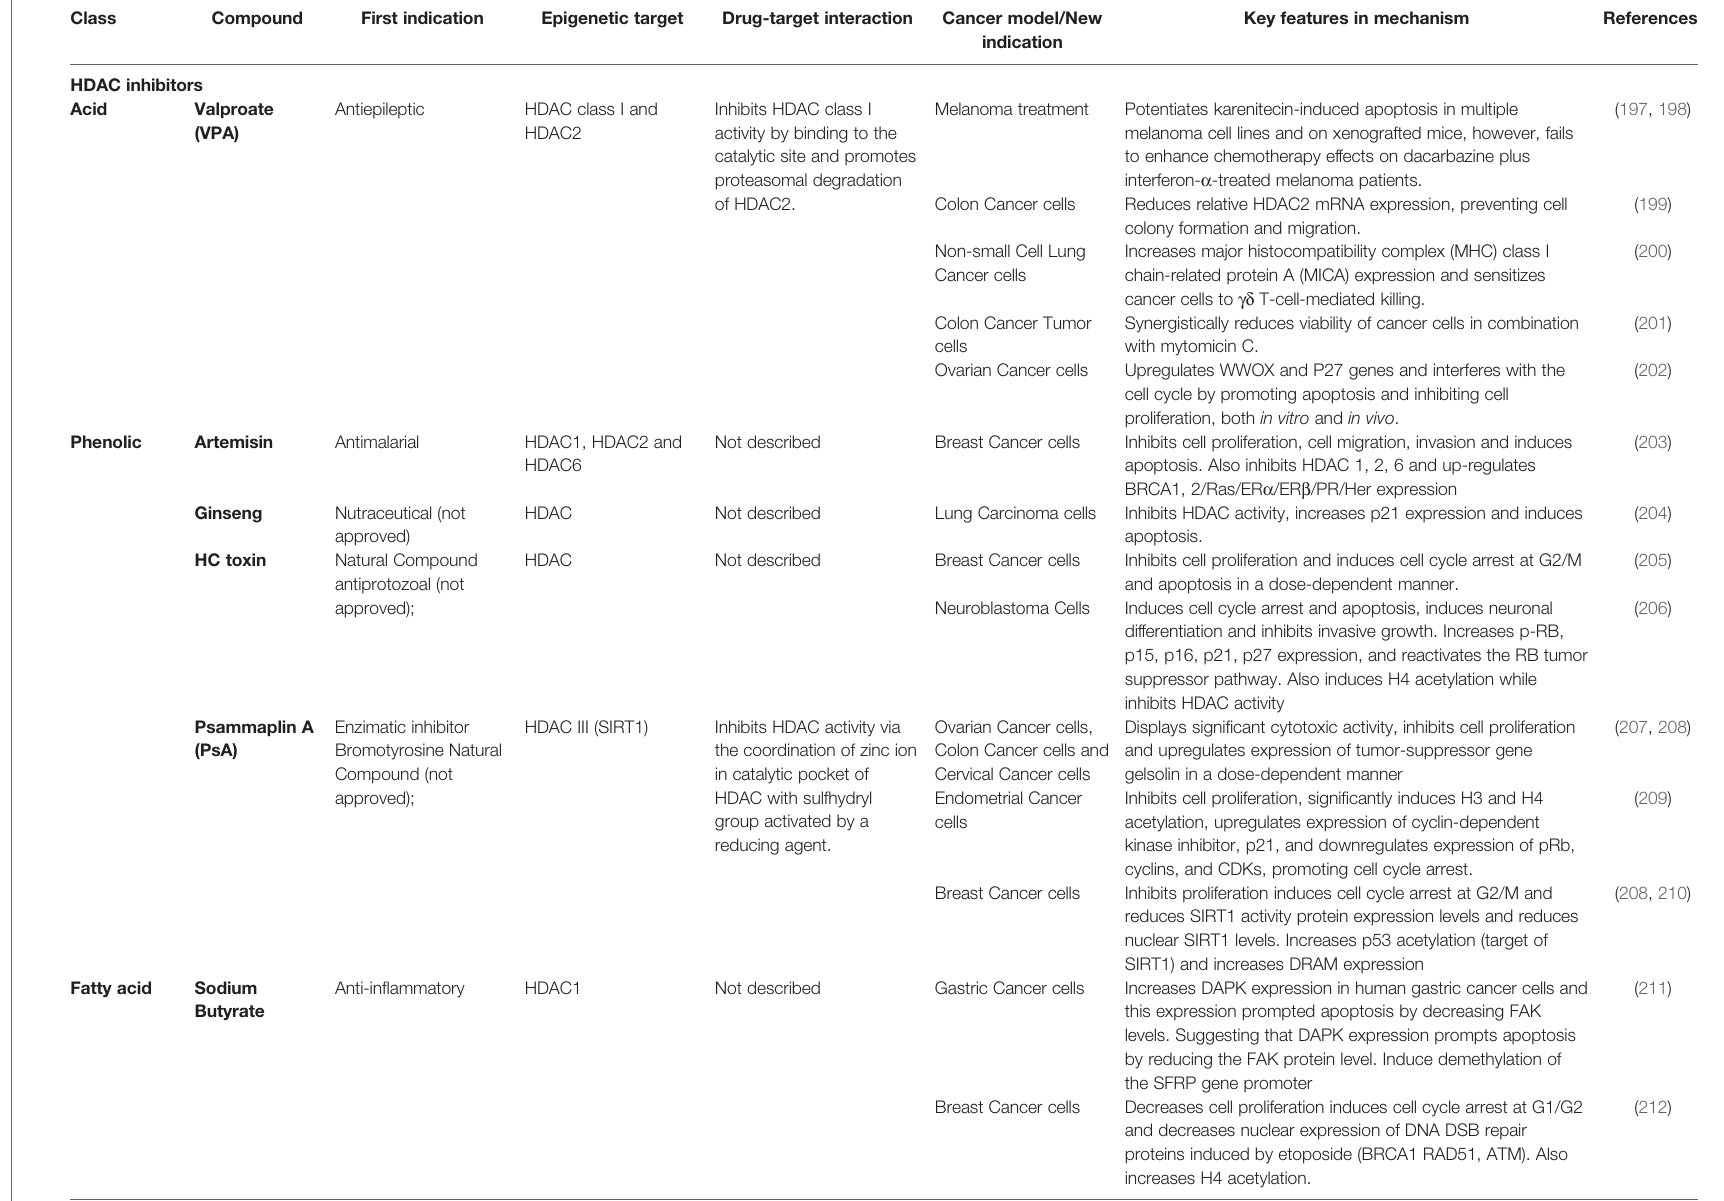
TABLE 5 | Current HDACi repurposed drugs with applications in cancer therapy [*modi fi ed from Moreira-Silva et al.